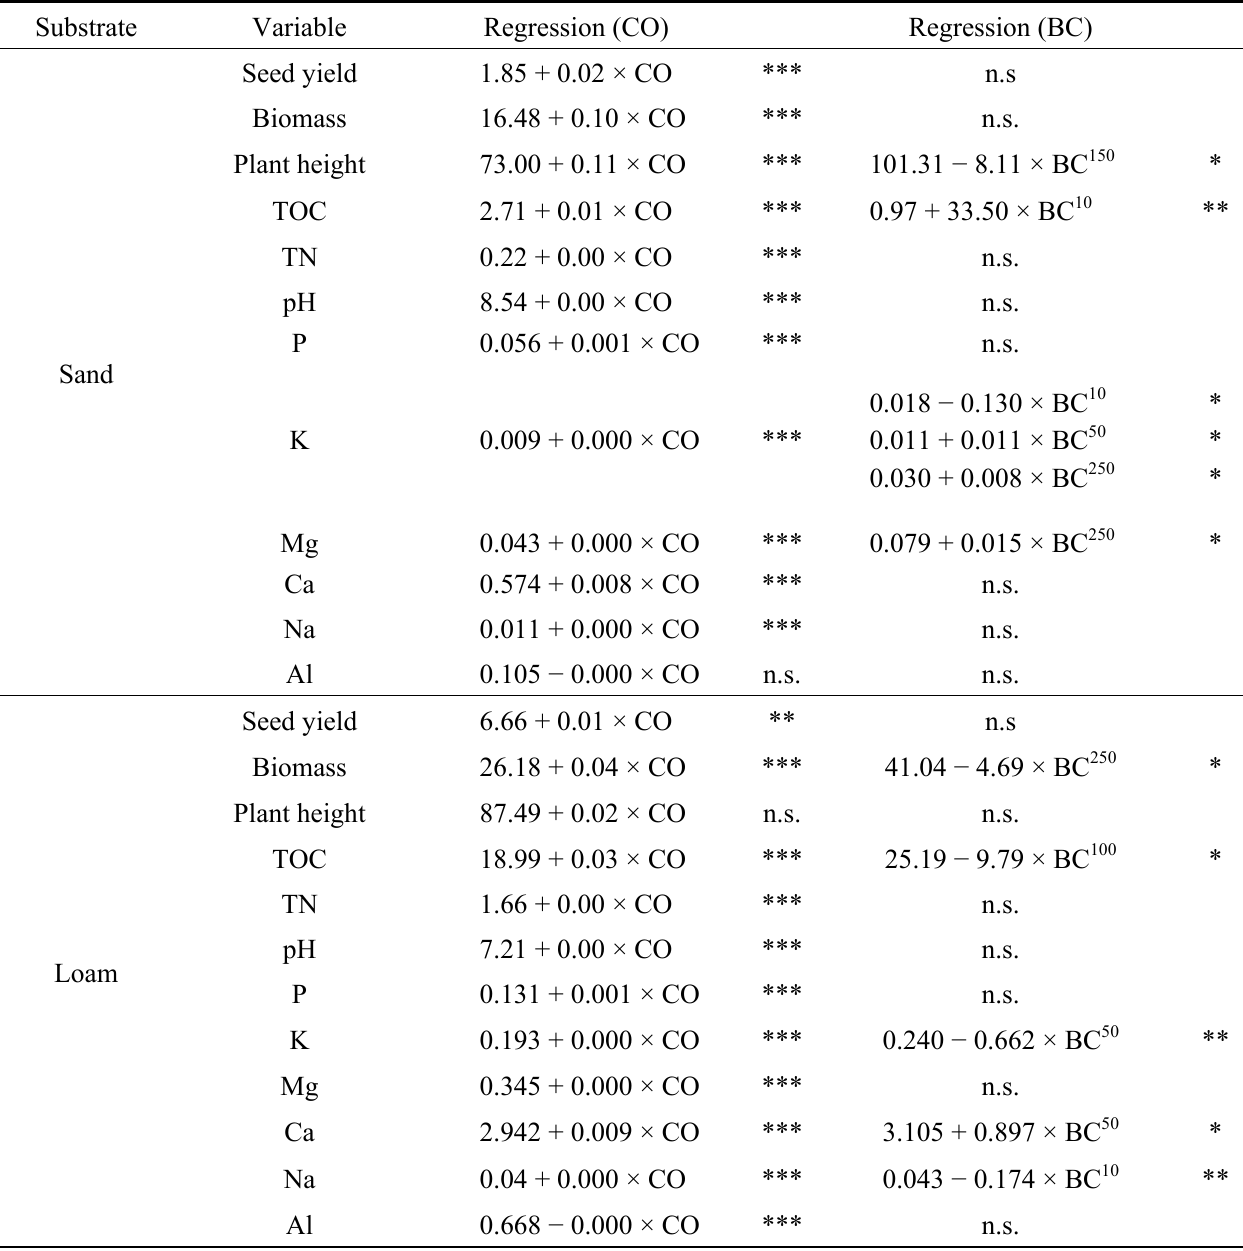
Table 2. Linear regression of plant and soil data calculated with per hectare amounts of the applied biochar composts. ―CO‖ stands for regressions with the compost amounts and the variables, ―BC‖ for the biochar amount and the variables. If ―BC‖ had significant influence on the variables, the respective application amount is indicated by the superscript